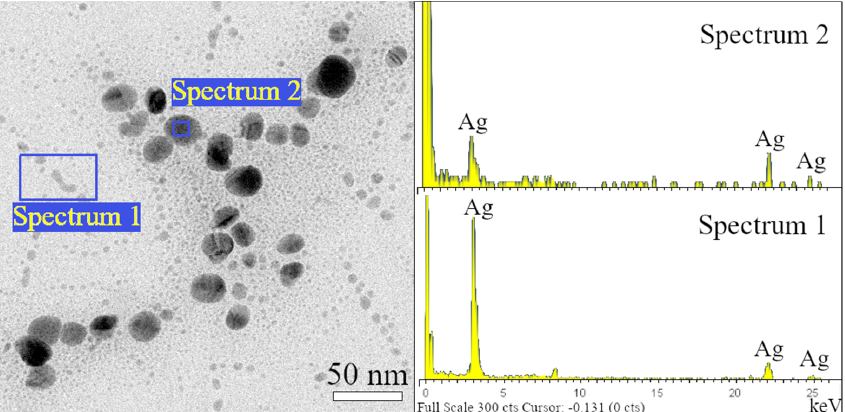
Figure 4. The energy dispersive X -ray spectroscopy of both size categories of AgNPs.